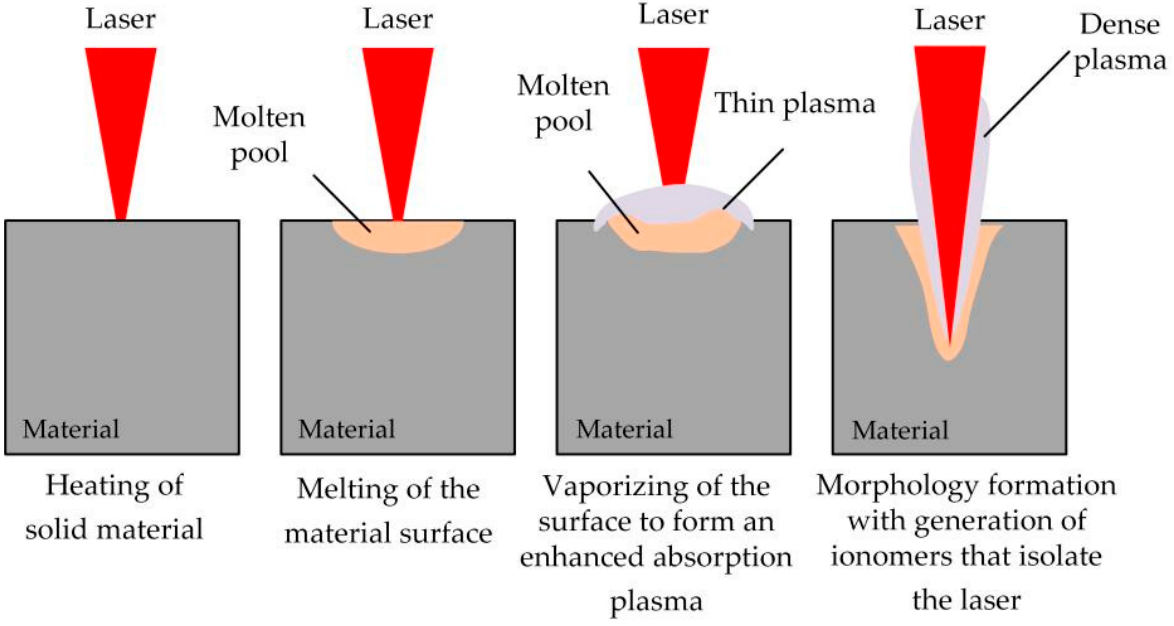
Figure 1. Schematic of the laser–material interactions.